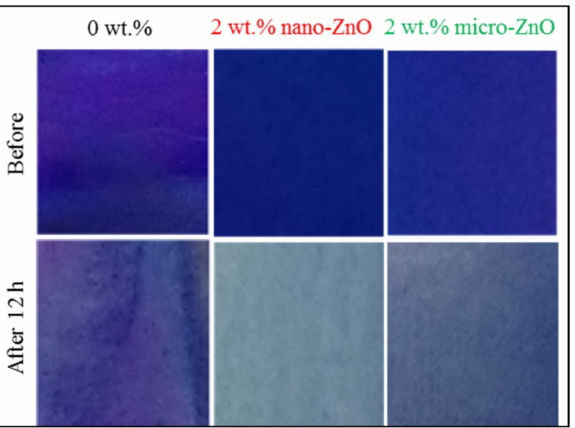
Figure 8. Photographs of methyl blue-contaminated coatings without or without ZnO particles, before and after 12 h of UV